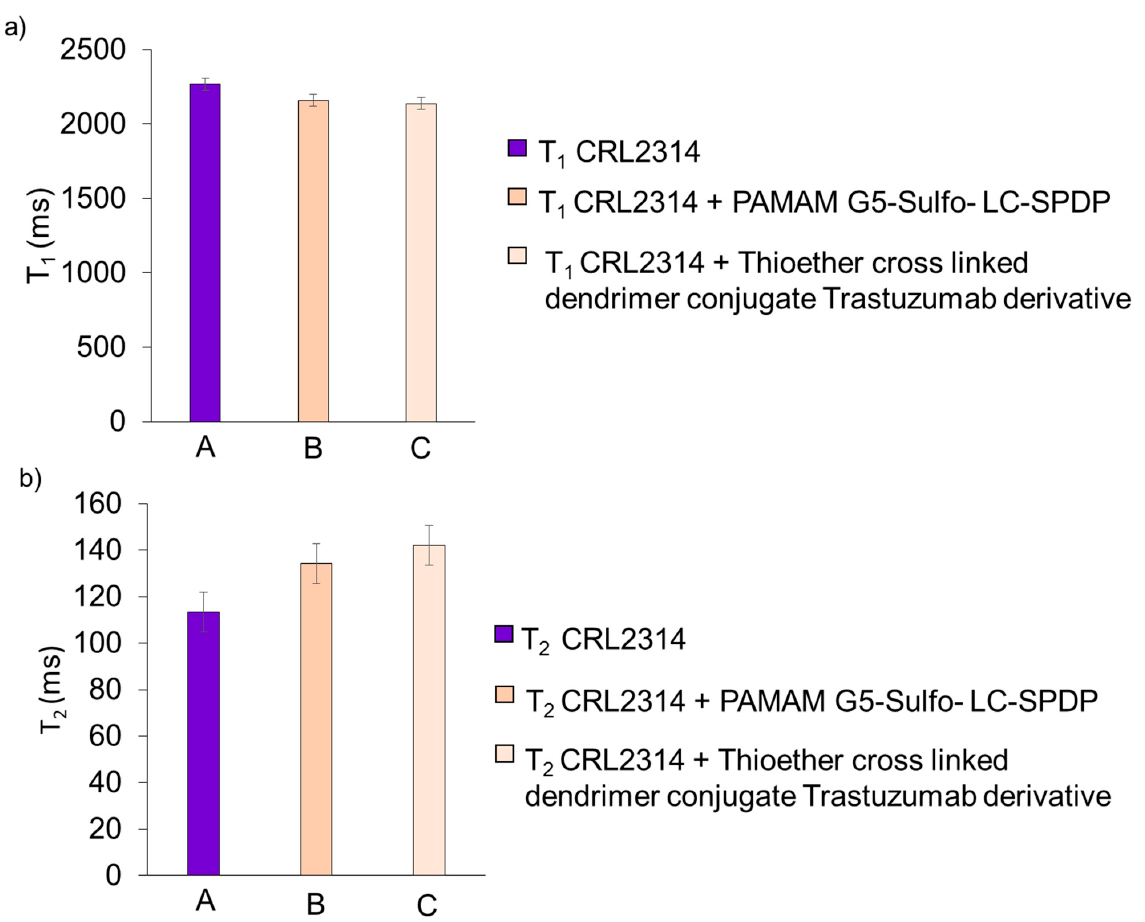
Figure 12. Results of T 1 ( a ) and T 2 ( b ) relaxation times for CRL-2314 monolayer cell culture (A), and the same culture with the addition of synthesized drugs 4 PAMAM G5-Sulfo- LC-SPDP (B) and 5 Thioether cross-linked dendrimer conjugate Trastuzumab derivative (C). The implementation of measurements using cultures in bioreactors made both qual- itative and quantitative measurements possible. Based on the measurements, maps of T 1 and T 2 relaxation times were created. Example relaxation time maps for the HTB-125 and CRL-2314 cell lines are shown below in Figures 13 and 14, respectively.